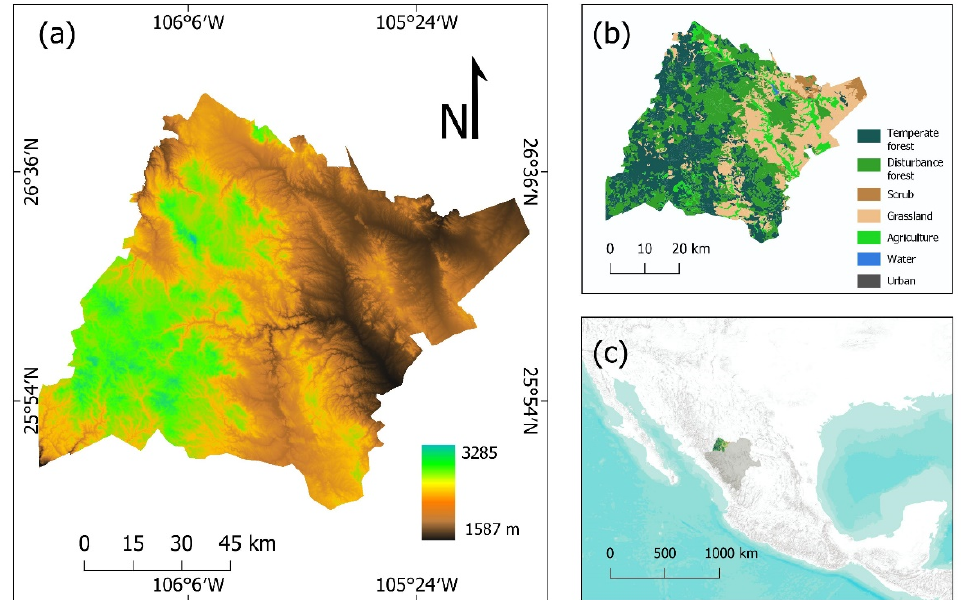
Figure 1. Study area. ( a ) Elevation; ( b ) Vegetation. The data on land use and vegetation were taken from information from the National Institute of Statistics and Geography of Mexico [50]. Temperate forests include pine forests, oak forests, and mixed forests. The disturbance forest classification corresponds to forests that suffered some alteration and are under a natural regeneration process; ( c ) Location of study area. Table 1. Path/Row and acquisition dates of Landsat-8